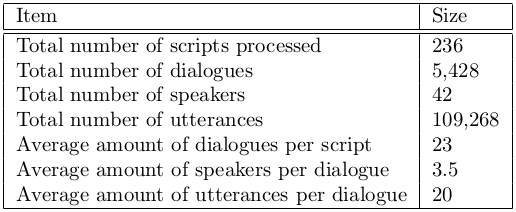
Table from the paper: Automatic Construction of Discourse Corpora for Dialogue Translation
Table text:
Item
Size
Totalnumberofscriptsprocessed
236
Totalnumberofdialogues
5,428
Totalnumberofspeakers
42
Totalnumberofutterances
109,268
Averageamountofdialoguesperscript
23
Averageamountofspeakersperdialogue
3.5
Averageamountofutterancesperdialogue
20